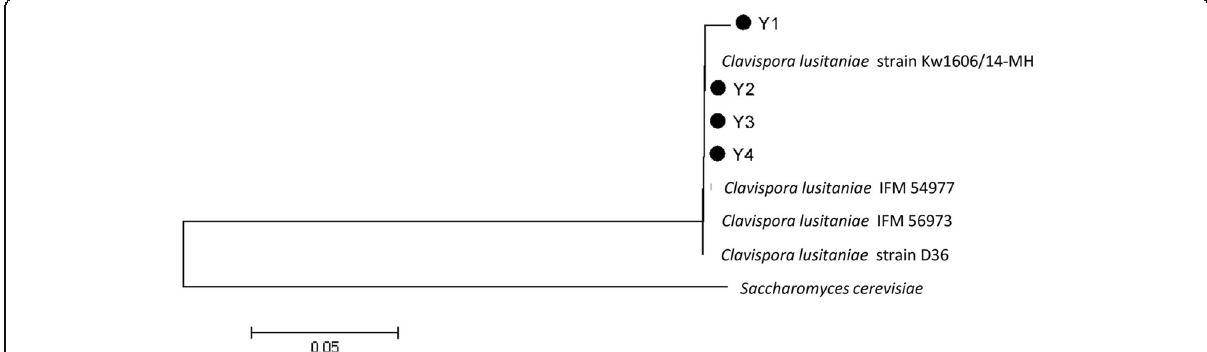
Fig. 3 A neighbor-joining phylogenetic tree based on ITS gene sequences of 4 yeast isolates (dark circles) with the closest hits obtained from the NCBI GeneBank